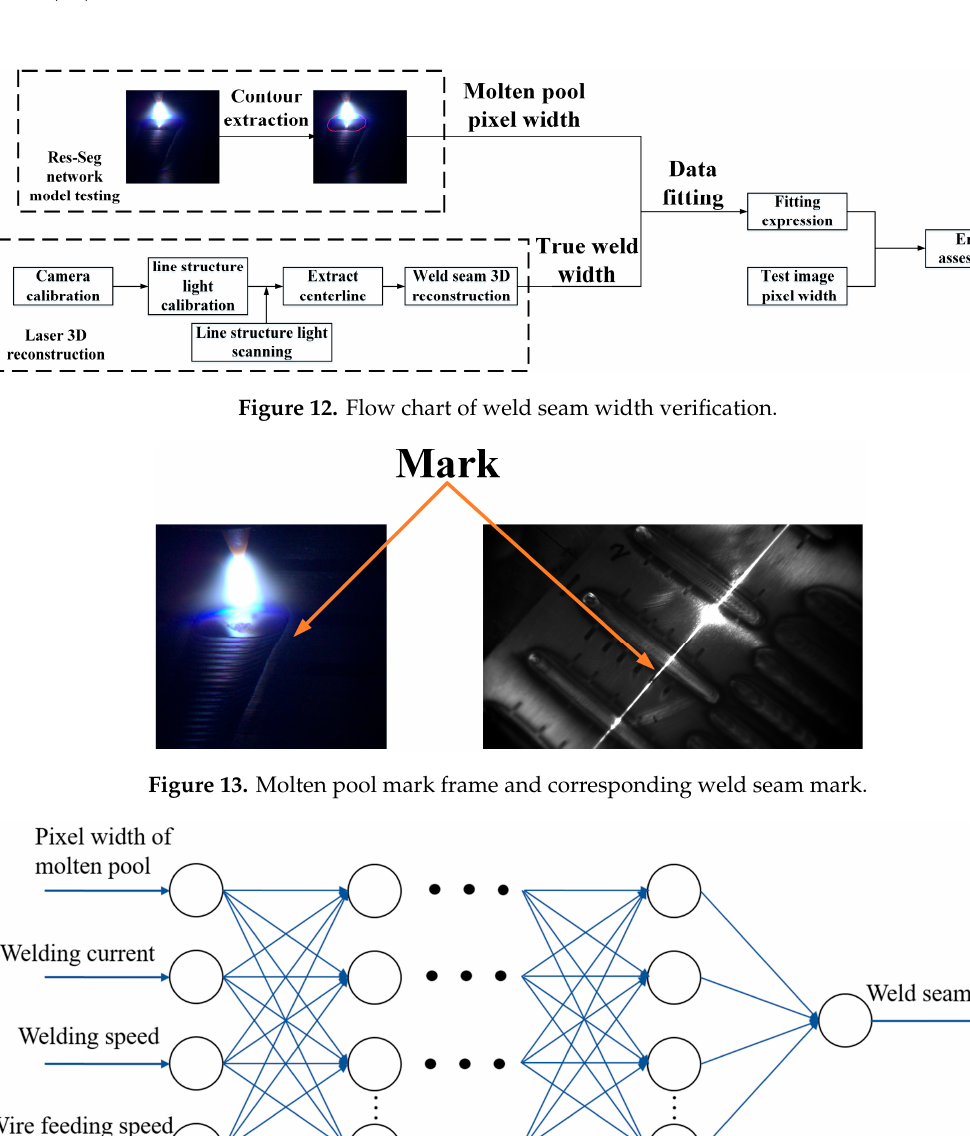
Figure 15. Error convergence curve in the training process of BP neural network. The BP neural network is used to test the test data, and the curve fitting method was used as the comparison experiment. The pixel width data of molten pool area is fitted with the corresponding weld width data, and the fitting equation is used to predict the test data. The comparison between